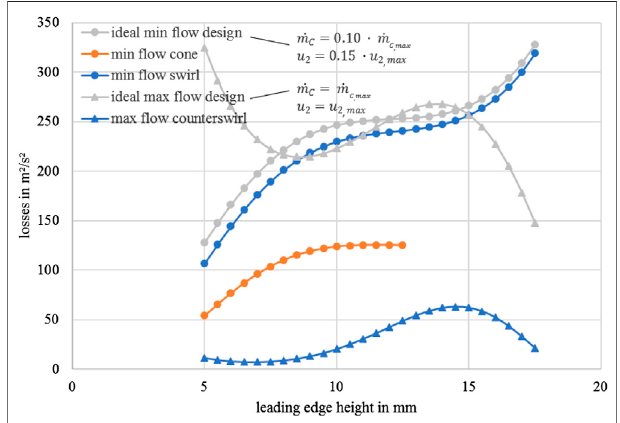
FIGURE 3 | Calculated incidence losses for different fl ow conditions at compressor inlet.